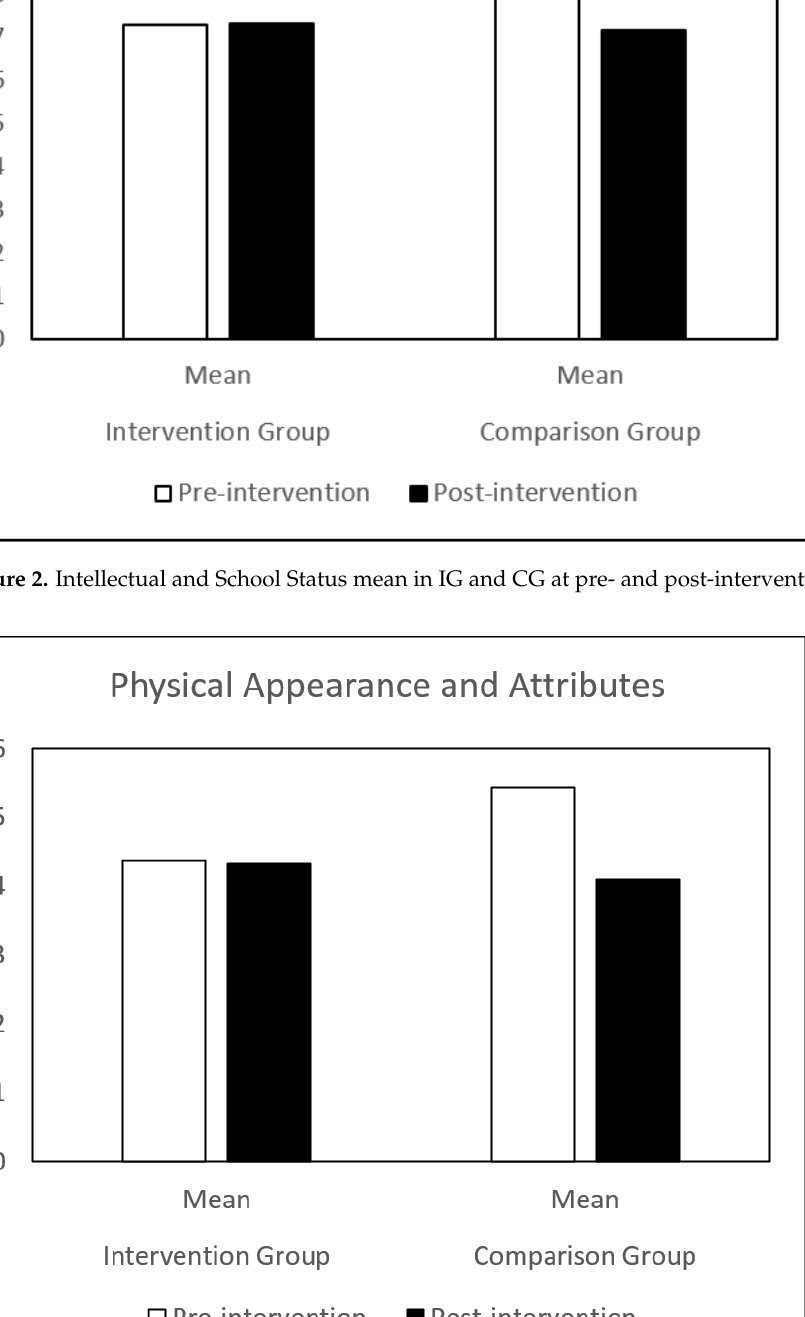
Figure 3. Physical Appearance and intervention. Intervention Attributes mean in IG and CG at pre- and post-intervention.